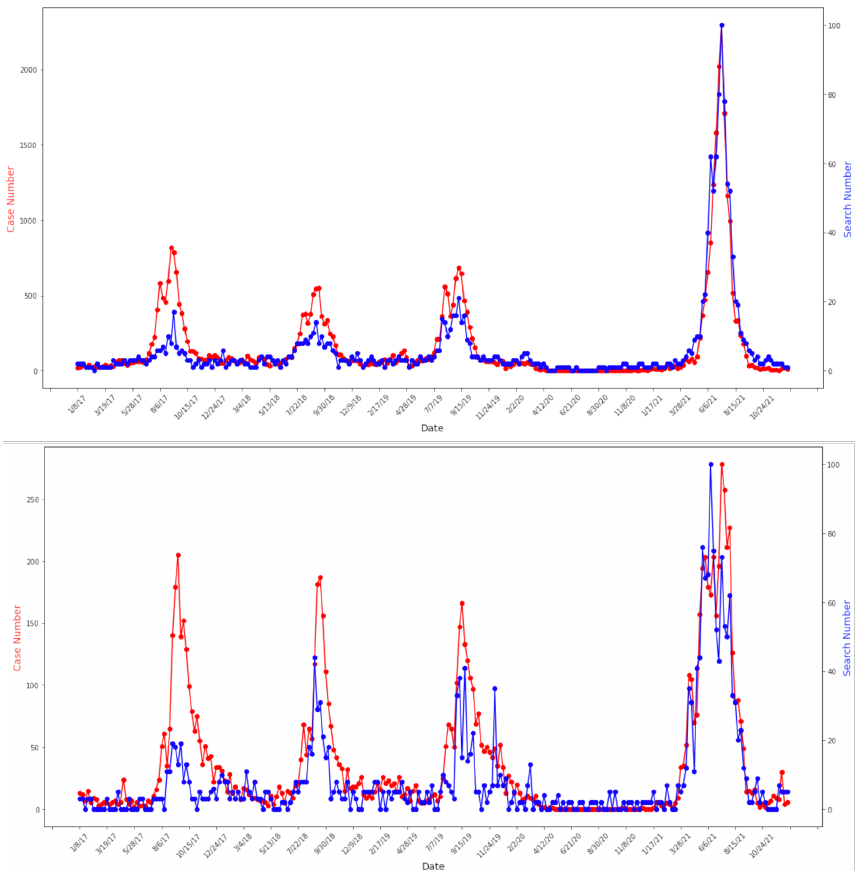
Figure 2. Correlation between Google Trends and case data at regional level: Tokyo 2017–2021 ( top ) Pearson correlation coefficient = 0.92. Kyoto 2017–2021 ( bottom ) Pearson correlation coefficient = 0.83. Both p -value < 0.0001. Google Trends and case data are marked in blue and red accordingly. Y-axis for both Google Trends and case data ranges from the minimum to the maximum values of each function over